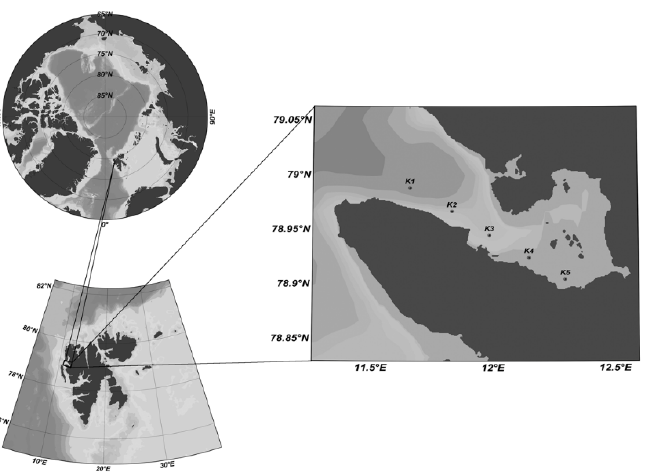
Figure 1. Sampling sites in Kongsfjorden of Svalbard: K1 to K5 were the five sampling stations from outer to inner fjord. Created by Ocean Data View (ODV 4.5, http://odv.awi.de accessed on 24 May 2016), and modified by Painter Windows Operating System in-built Toolkit of image editor (adopted from Zhang et al. [16], Reproduced with permission from [Zhang et al., 2019].).